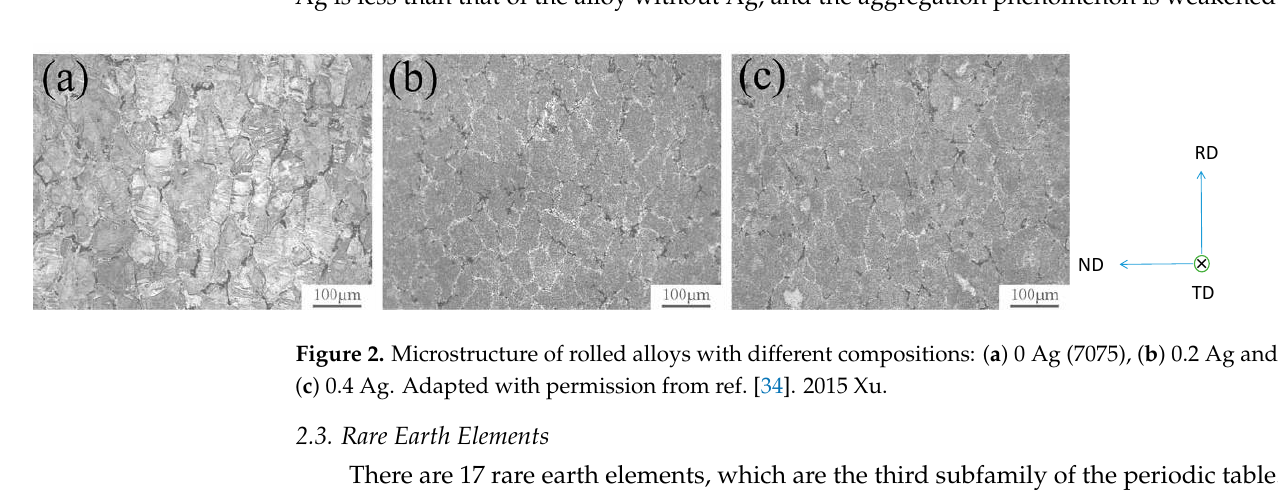
Figure 1. XRD pattern of as-cast 7075 (0 Ag) alloy and 0.4 Ag alloy. Adapted with permission from ref. [34]. 2015 Xu.